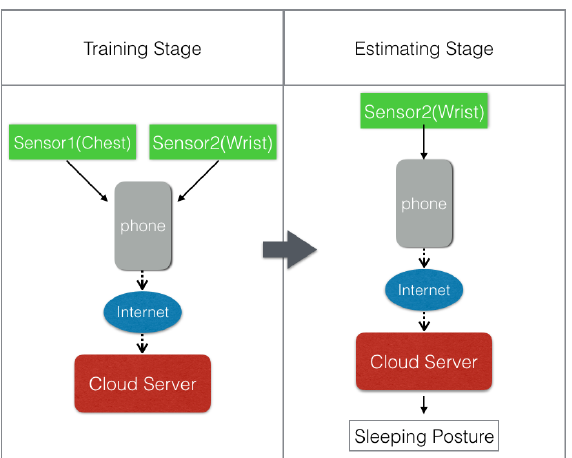
Figure 5. The two operation phases for iSleePost monitoring system: (1) training phase, (2) monitor- ing phase. In the training phase, both chest and wrist sensors are required. In the monitoring phase, only wrist sensor is